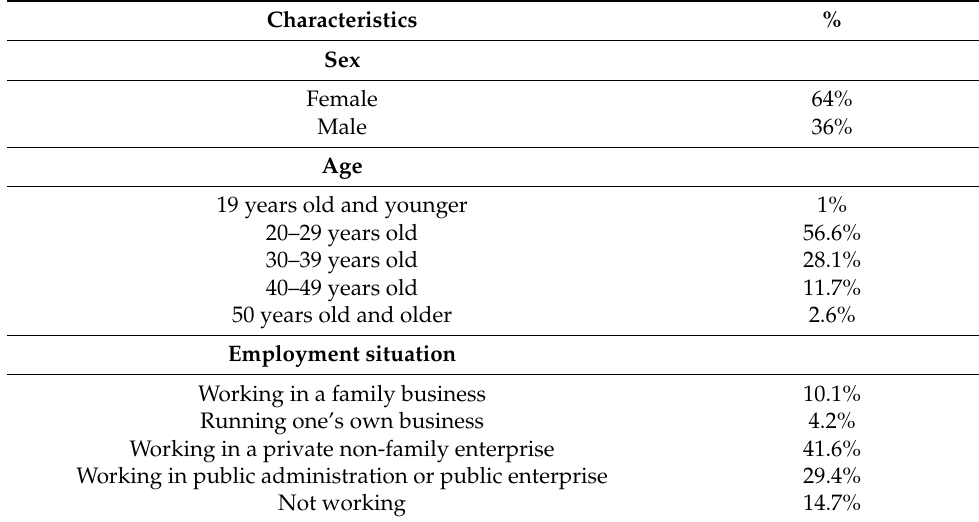
Table 2. Structure of respondents in the first survey.